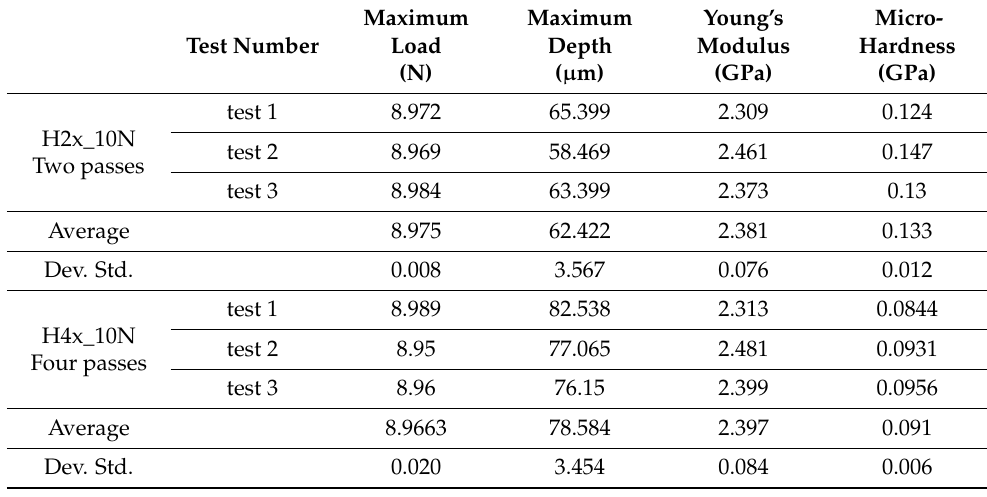
Table 8. Square (S) texture values.